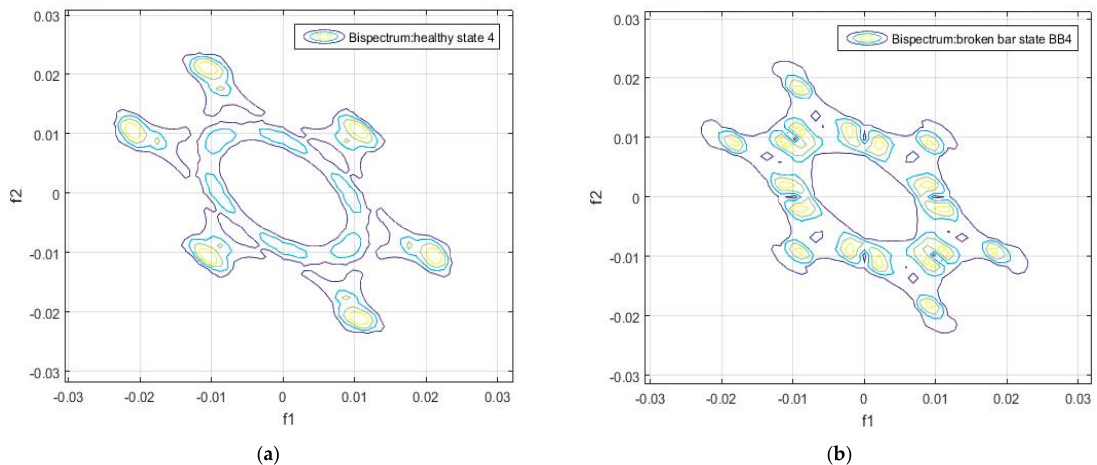
Figure 5. Contour of the bispectrum of the motor flux signal: ( a ) Sample 3 of the healthy motor and ( b ) Sample 3 of the damaged motor.